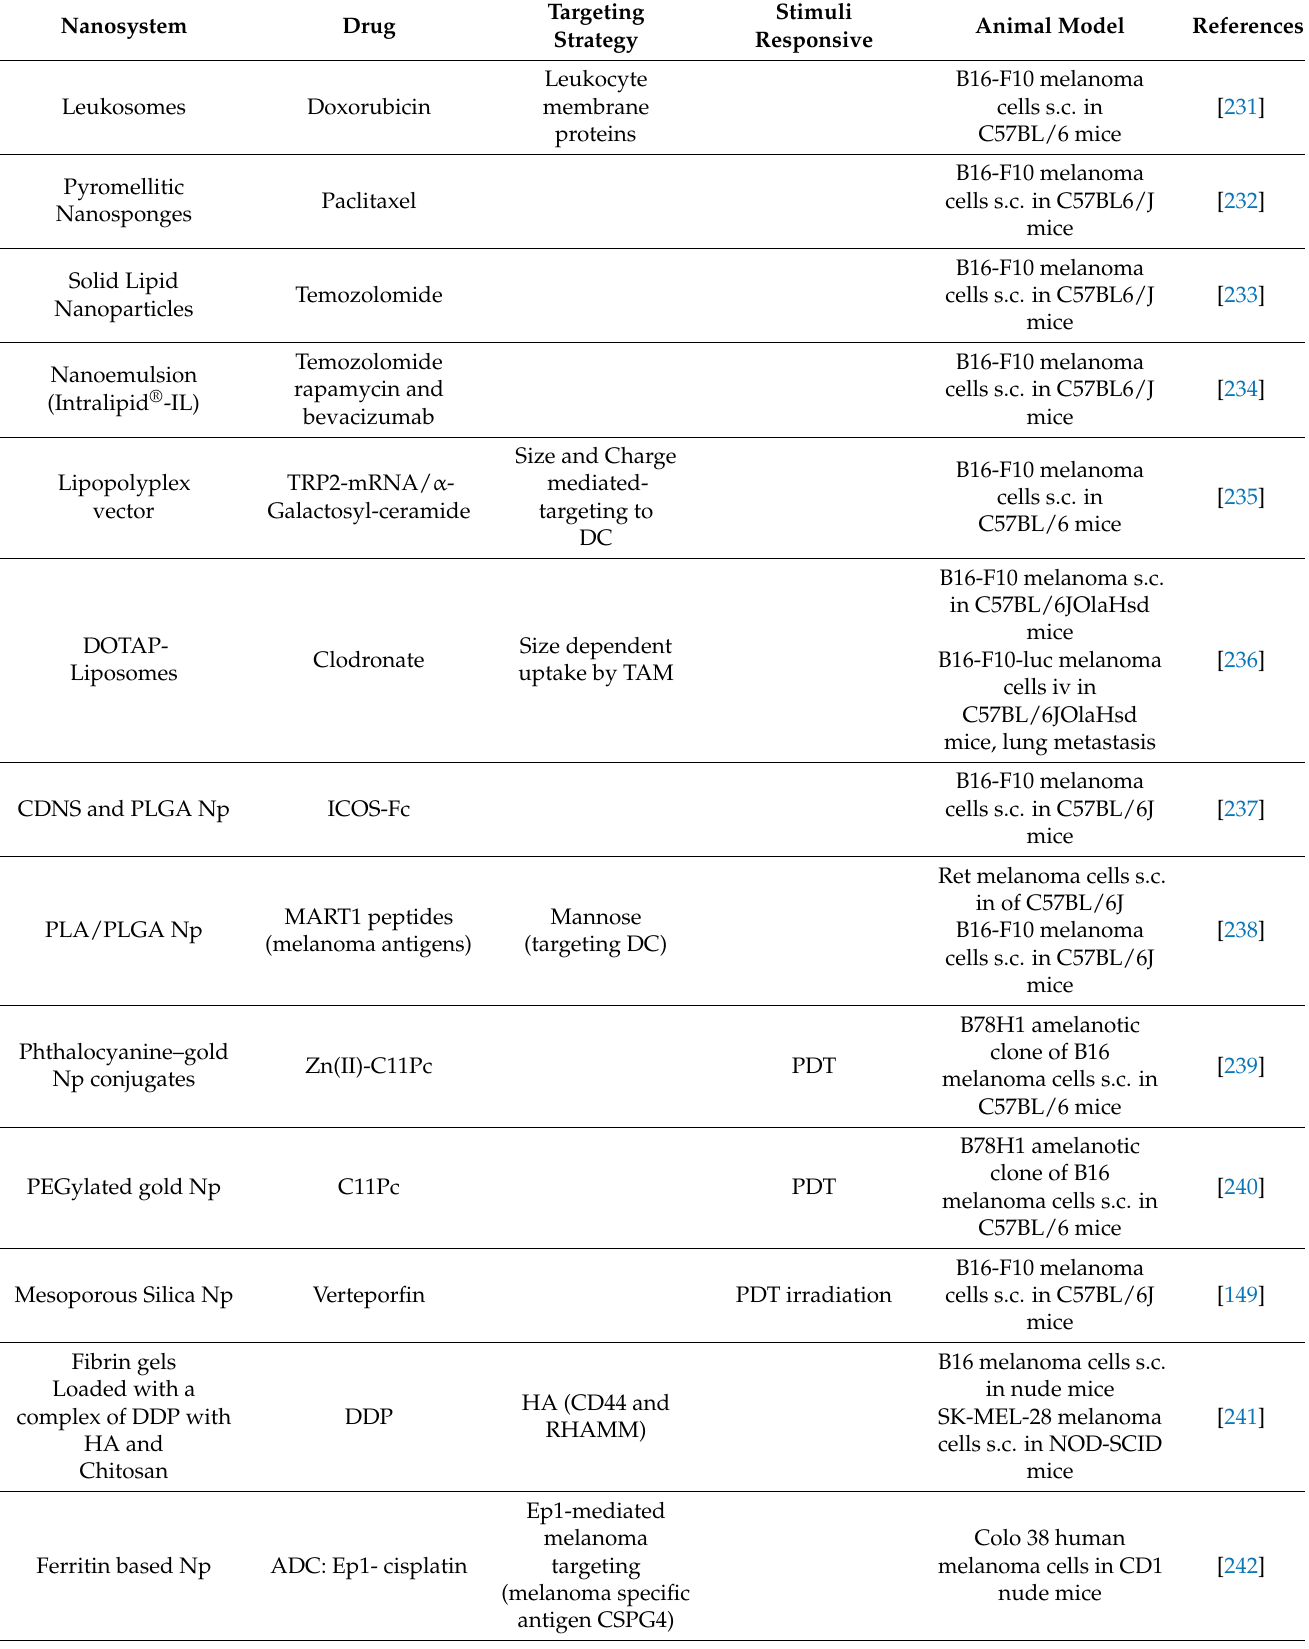
Table 3. Nanomedicines developed in Italy in advanced pre-clinical